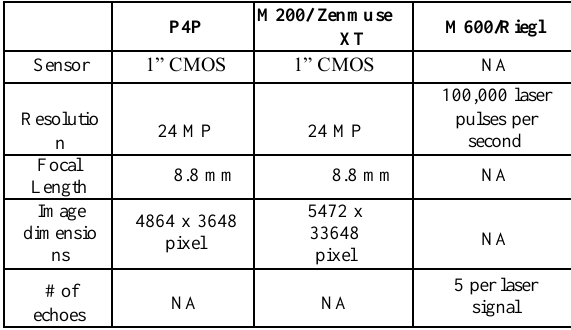
Table 1: Overview of data capturing